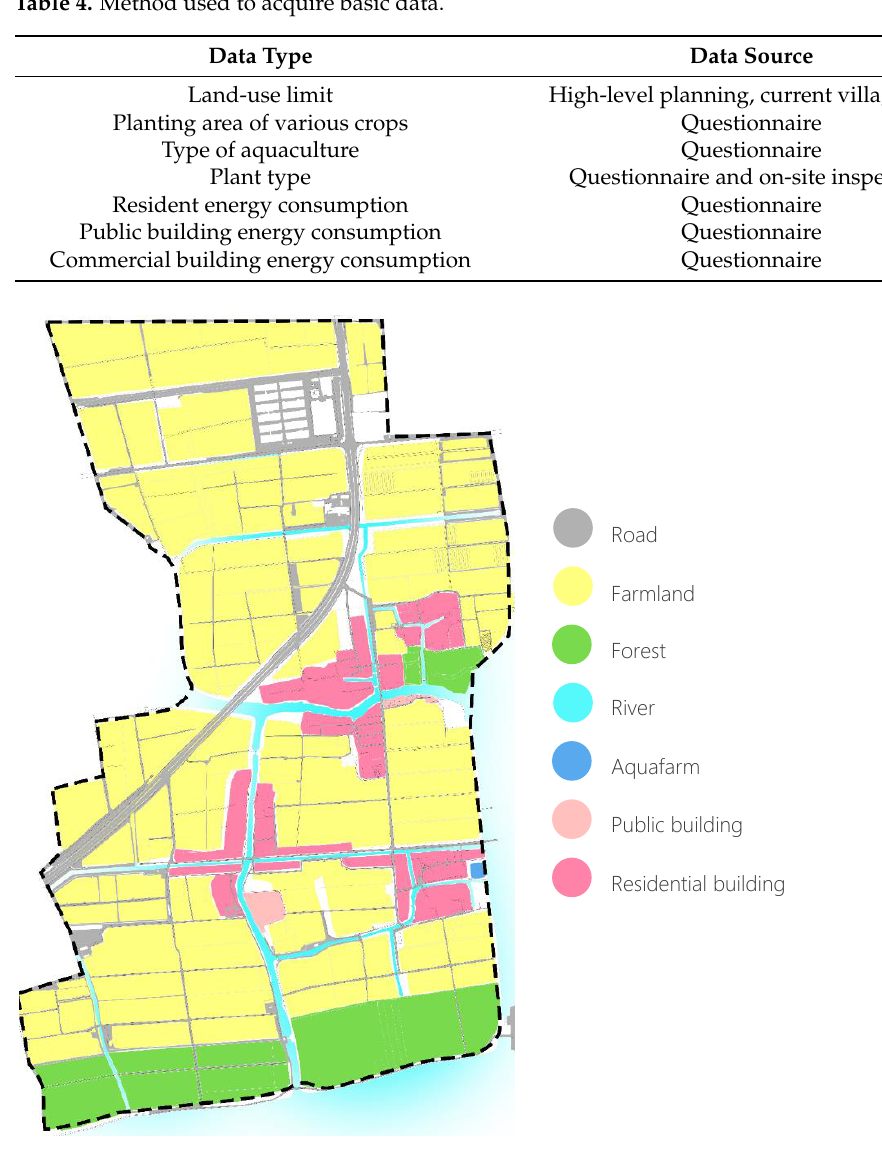
Figure 4. Base map of Dongzhuang Village.